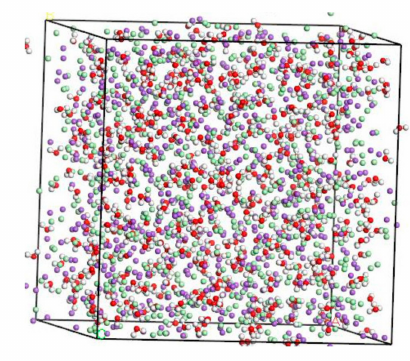
Figure 2. Molecular modeling of NaCl solution (purple balls are Na + , light green balls are Cl − , red balls are O atoms, white balls are H